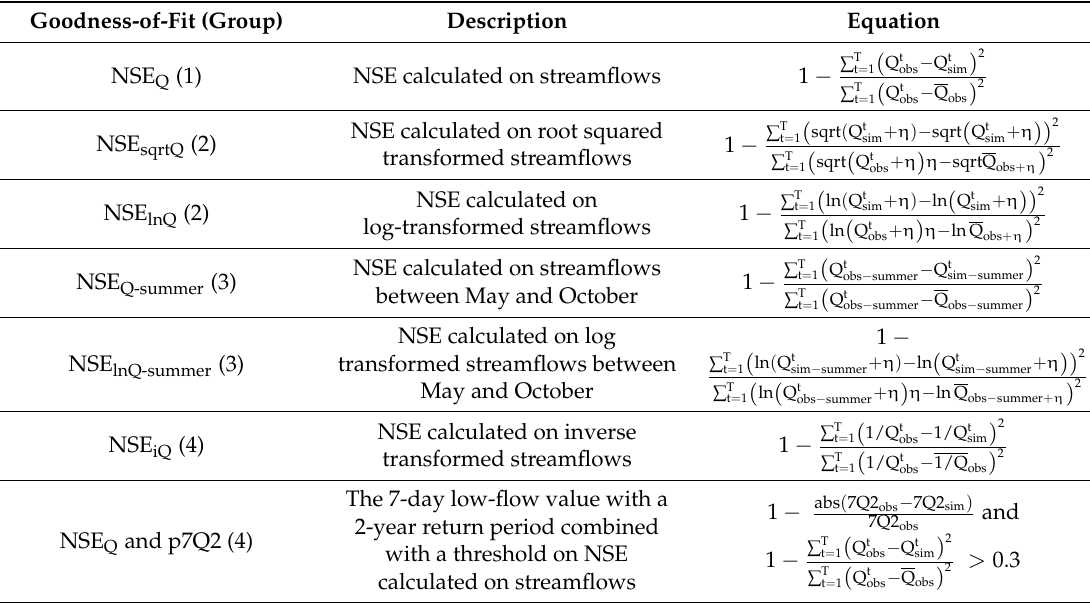
Table 2. Description of the seven goodness-of-fit criteria used as objective functions for the model calibration and to evaluate model